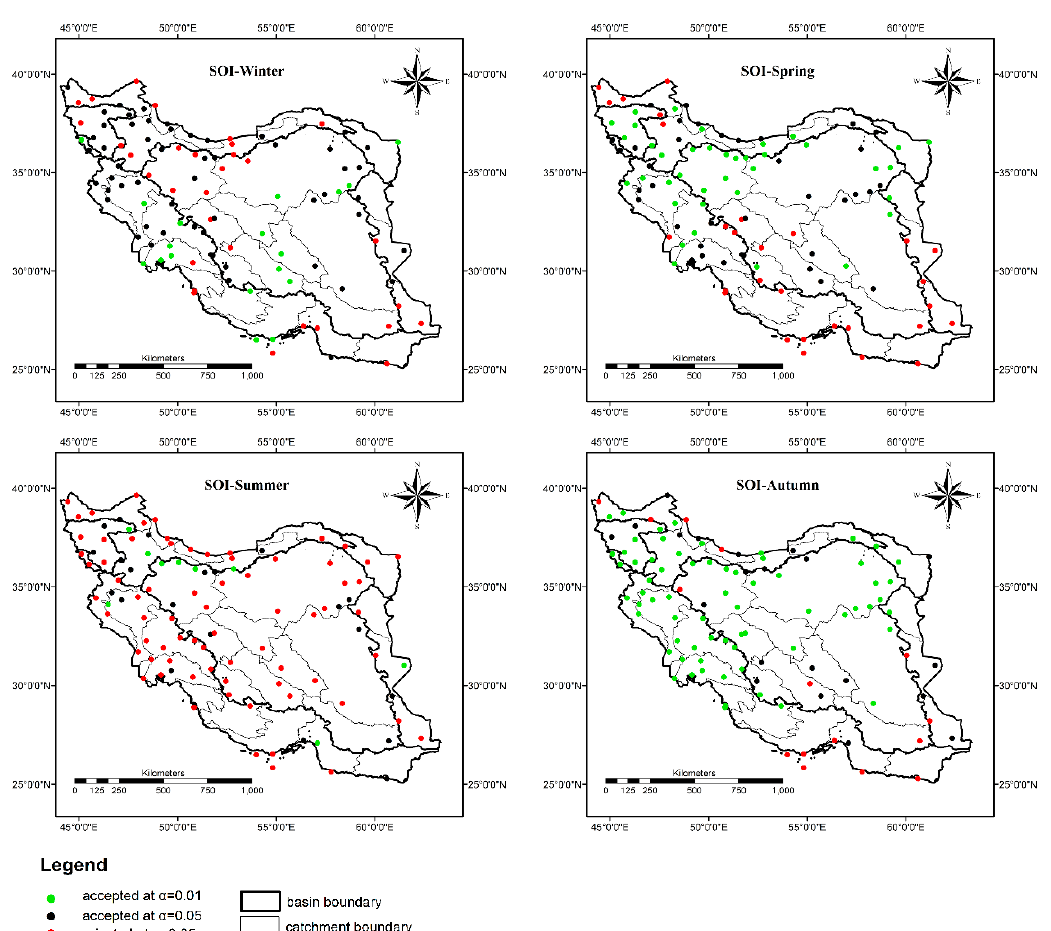
Figure 3. Results of statistical test for correlation between seasonal precipitation and climatic indices.